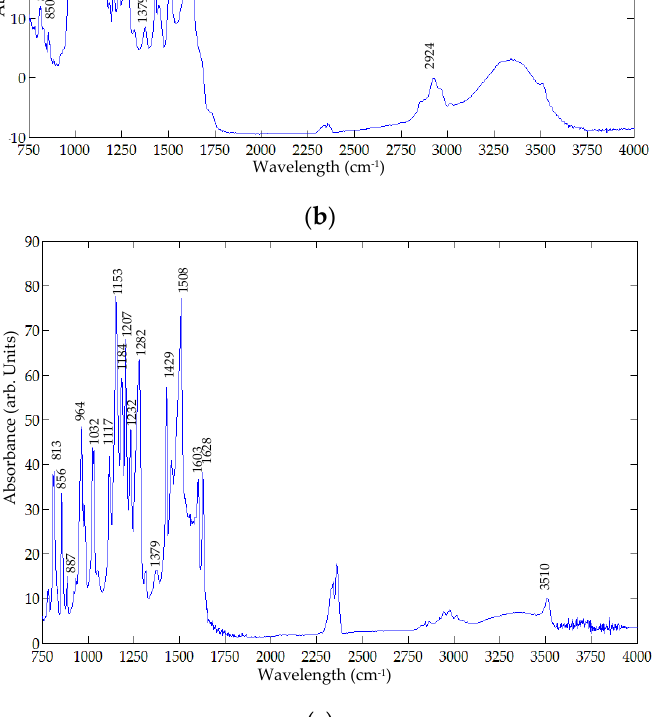
Figure 3. Fourier Transform-Infra Red (FT-IR) spectra of: ( a ) Metanil yellow; ( b ) Turmeric powder; ( c ) Curcumin.